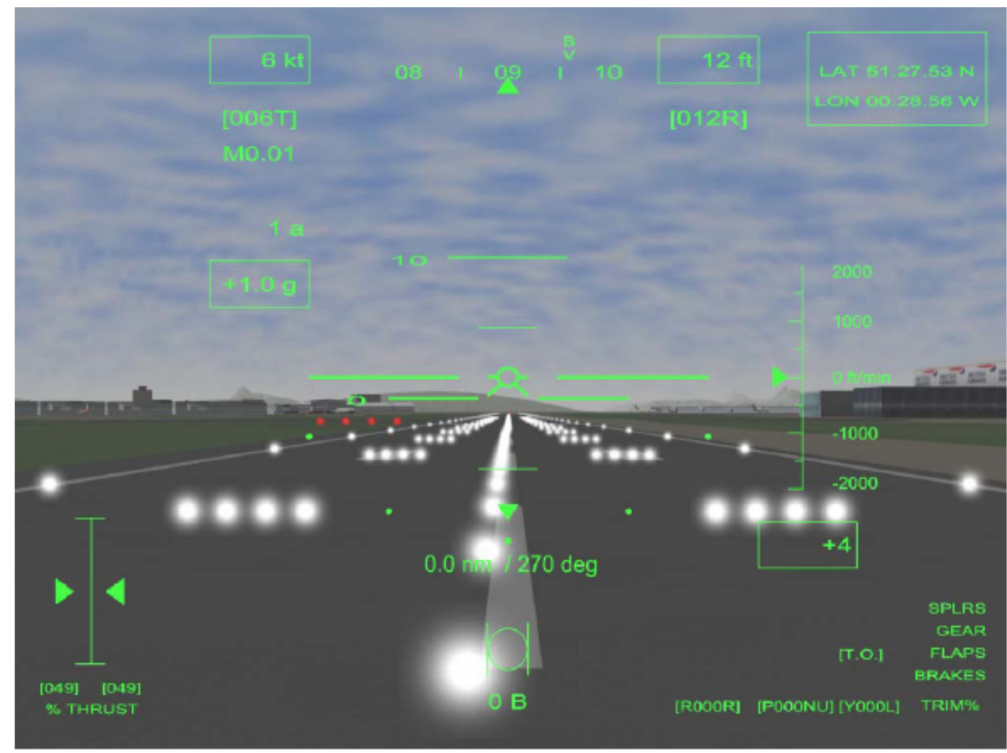
Figure 8. Engineering flight simulator main console head up display showing flight parameters (from [35], copyright to Merlin Flight Simulation Group).